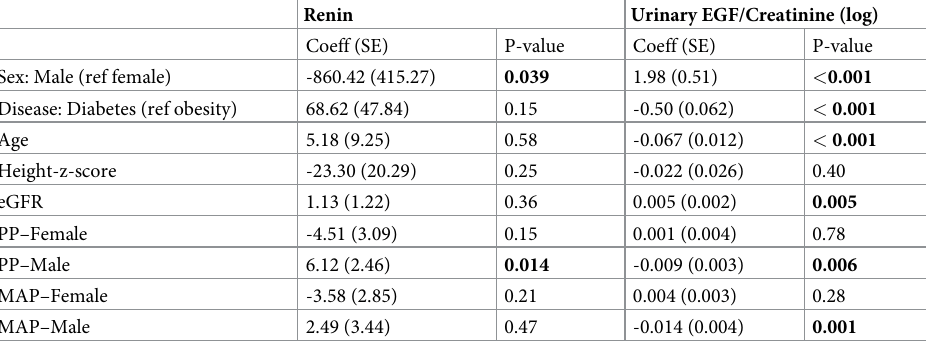
Table 3. Multiple linear regression models.